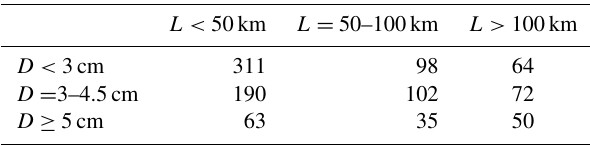
Table 1. Number of HS events in the respective classes of maximum hail size diameter D and track length L